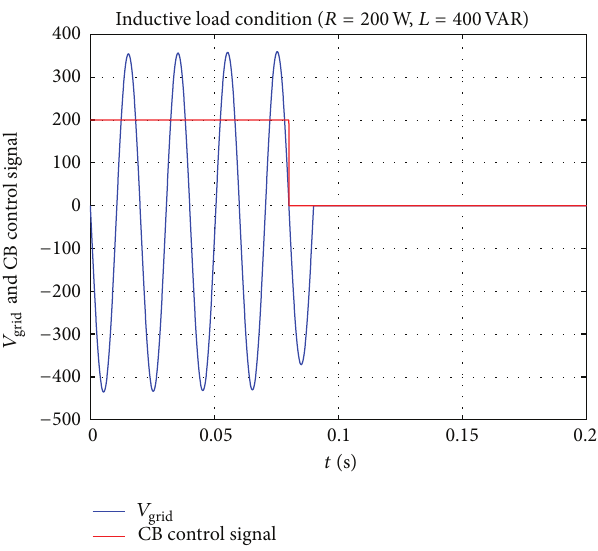
Figure 10: The inductive load condition ( 𝑃 = 200 W and 𝑄 𝐿 = 400